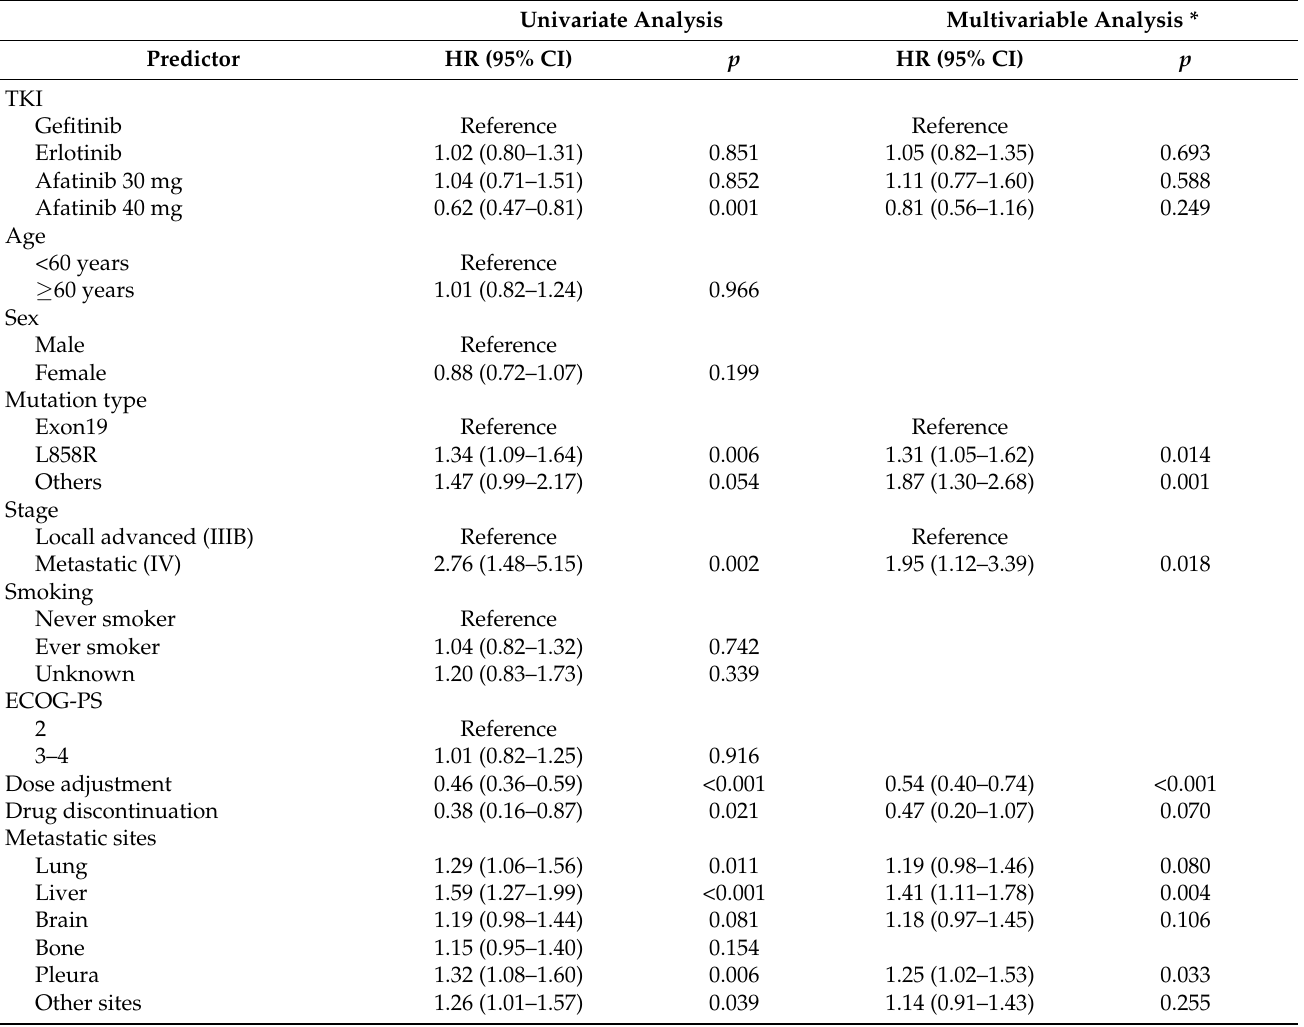
Table 2. Univariate and multivariable analysis for the associated factors with progression-free survival. Univariate Analysis Multivariable Analysis